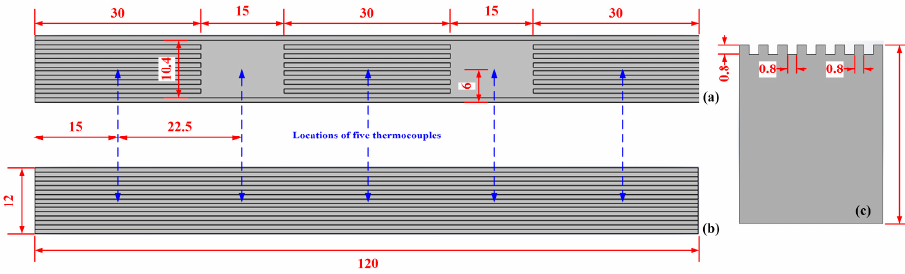
Figure 6. Structure of continuous and segmented heat sink (unit: mm): ( a ) Top view of segmented microchannel; ( b ) Top view of continuous microchannel; ( c ) Side view.